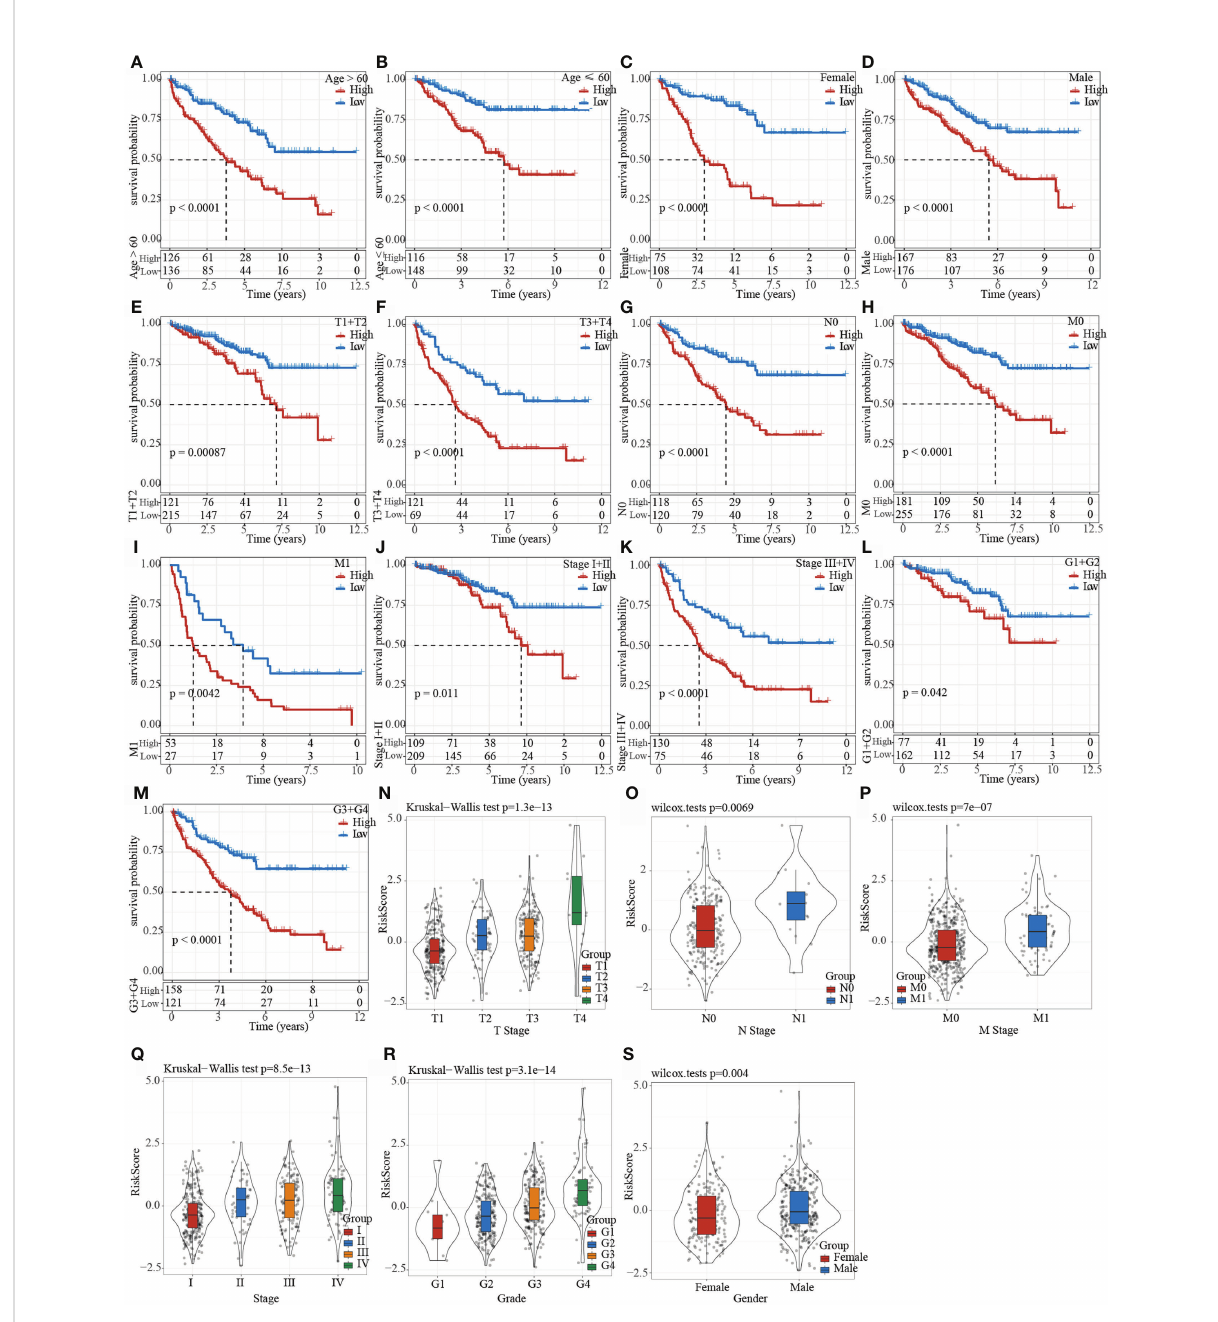
FIGURE 9 Clinical subgroup survival analysis and correlation analysis based on Riskscore. (A – M) Prognostic survival curve of clinical characteristics based on Riskscore; (N – S) RiskScore comparison in clinical characteristics of TCGA data